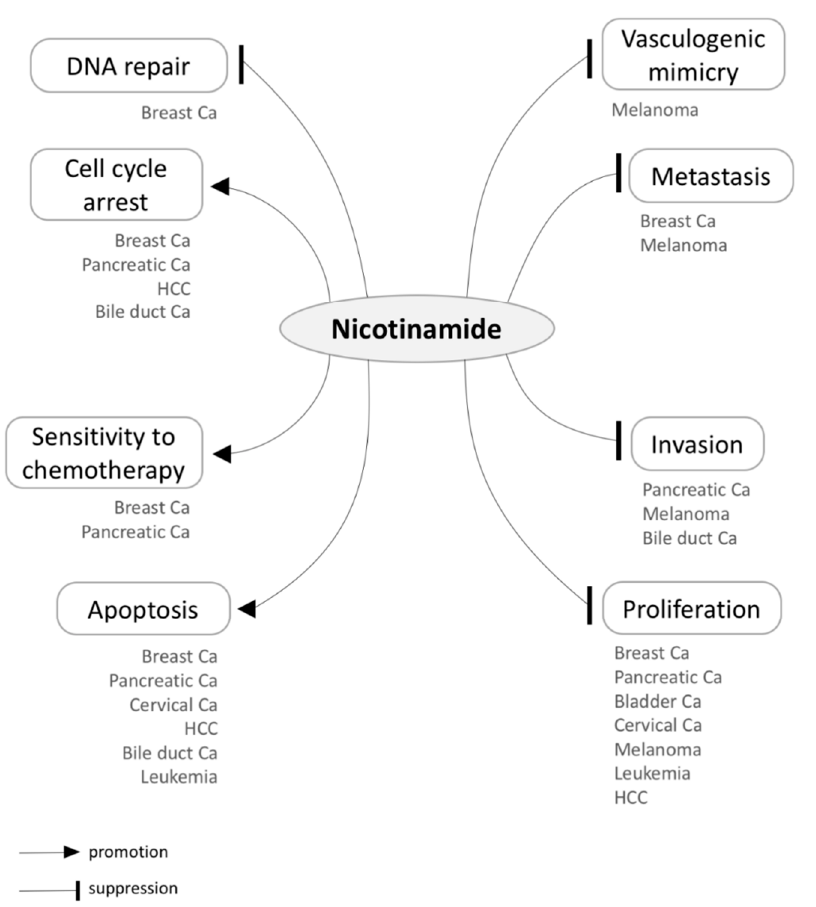
Figure 3. Tumor suppressive effects of Nicotinamide (NAM) in a variety of cancers. Below each of the distinct processes influenced by NAM, the associated cancer types are listed according to the existing literature. HCC, hepatocellular carcinoma; Ca, carcinoma.